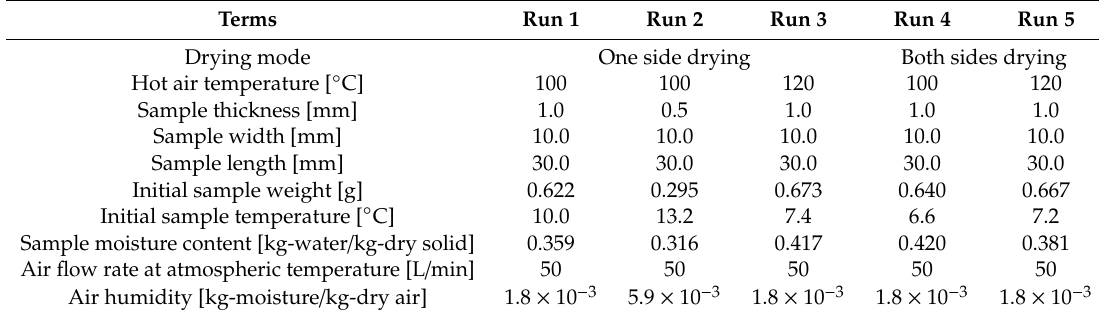
Figure 4. Outline of hot-air drying experimental setup (both sides drying of sample). Table 1. Experimental